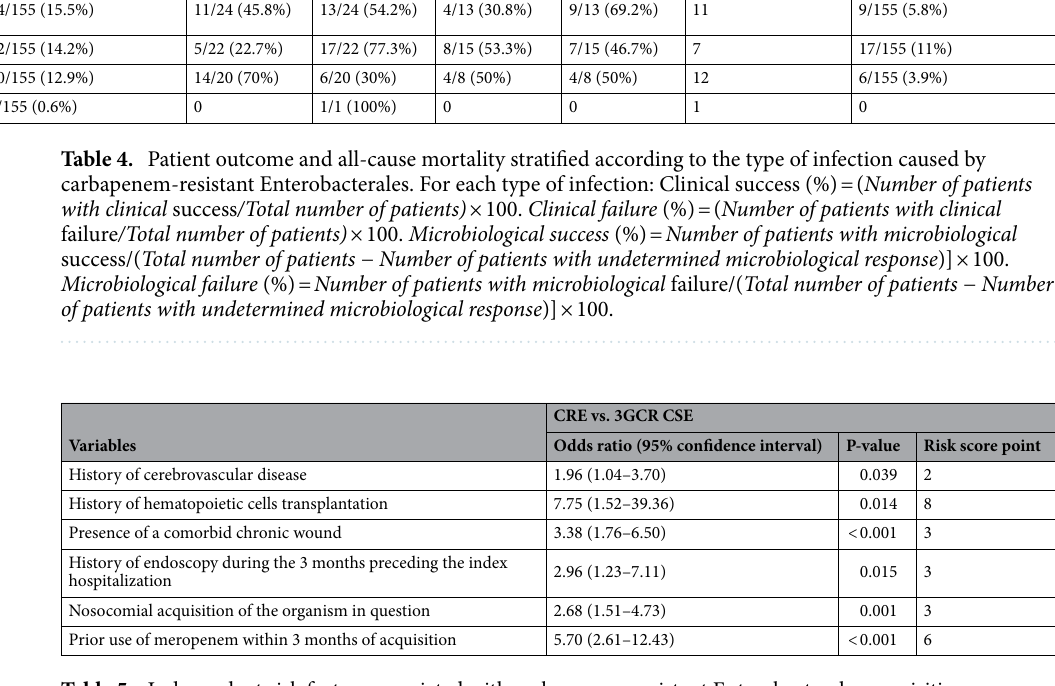
Table 5. Independent risk factors associated with carbapenem-resistant Enterobacterales acquisition as determined multivariate logistic regression analysis and the assigned risk score points.